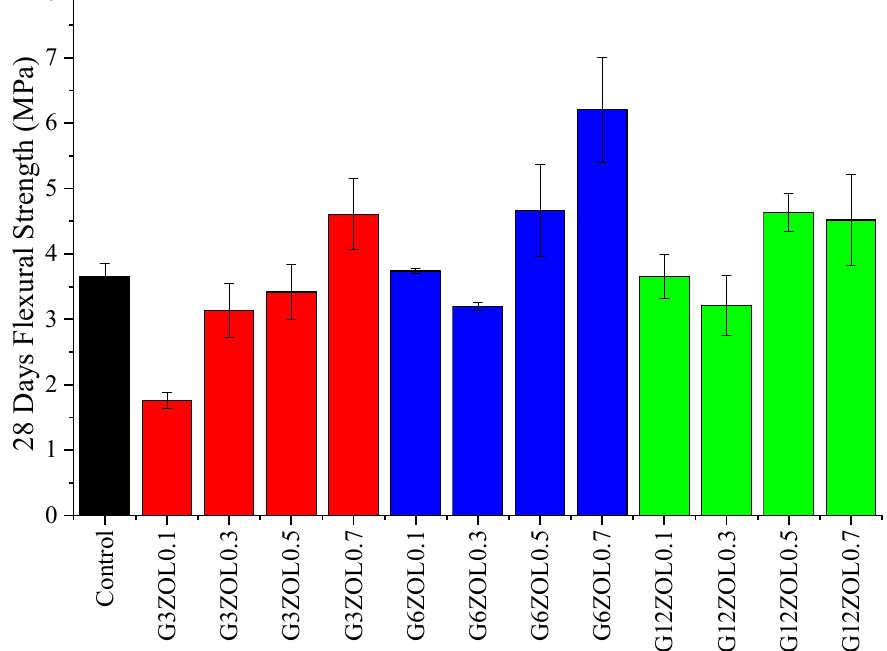
Figure 4. Flexural strength variation of the geopolymer mixes.